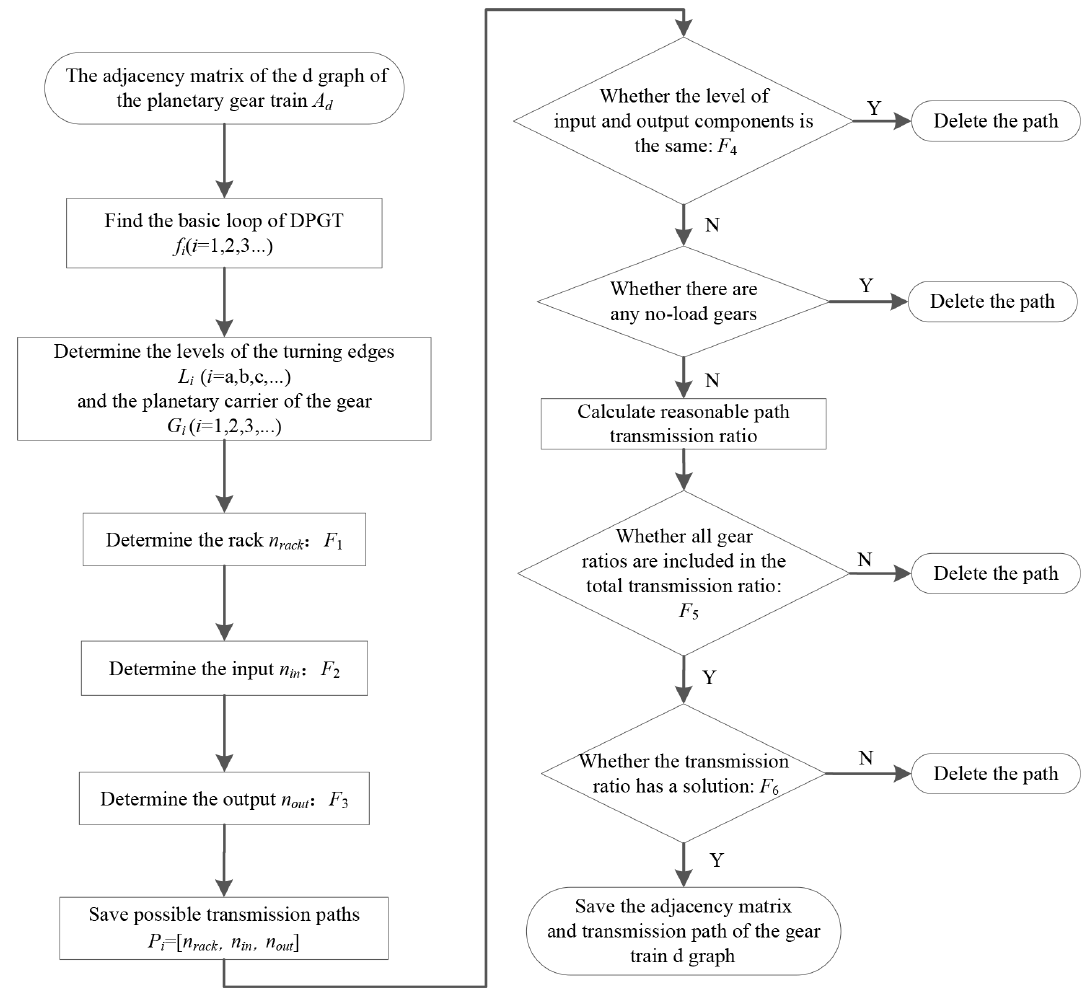
Figure 8. Flowchart of the DPGT creation.